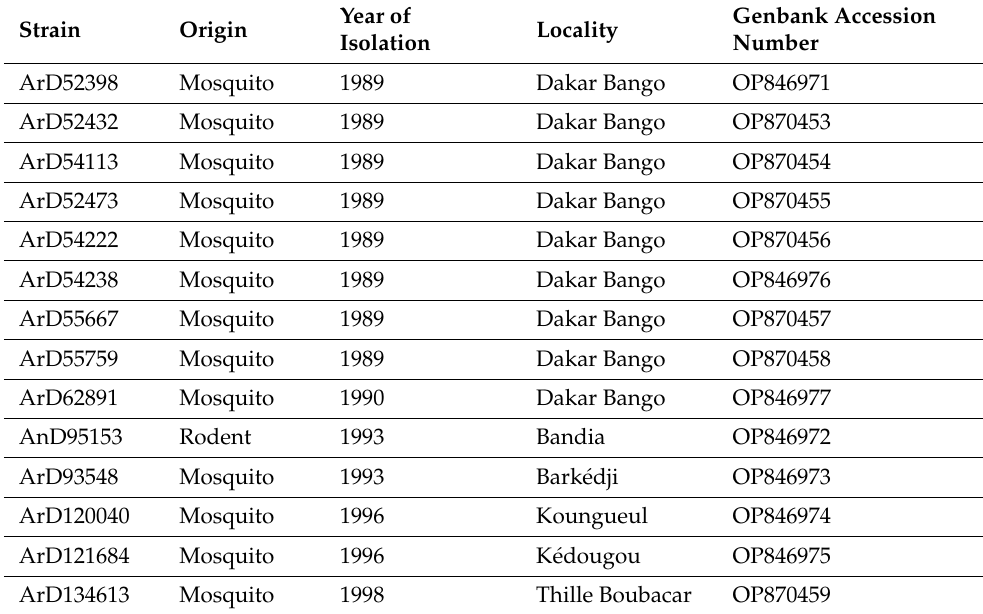
Table 4. ID of the new sequenced strains for WNV phylogenetic characterization in Senegal, the hosts from which they were isolated, their years of isolation, the locality of isolation and their Genbank accession numbers have been specified on this